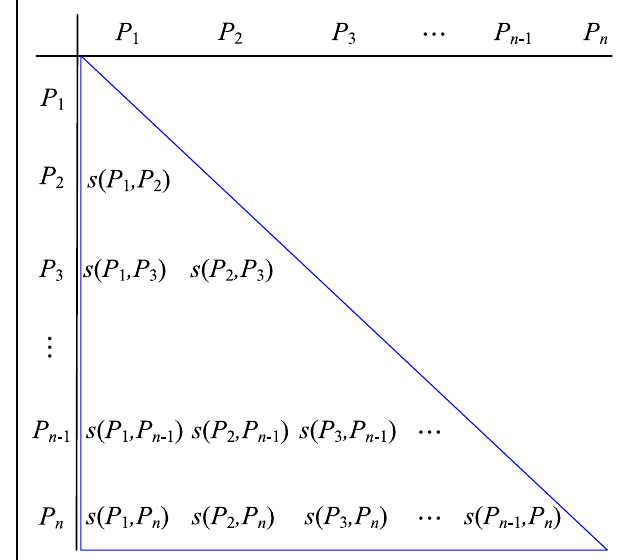
FIGURE 4 | The matrix to show how to calculate the stability of routes. s ( P i , P j ) means the similarity between permutations P i and P j , which is calculated based on Eq. 2 .